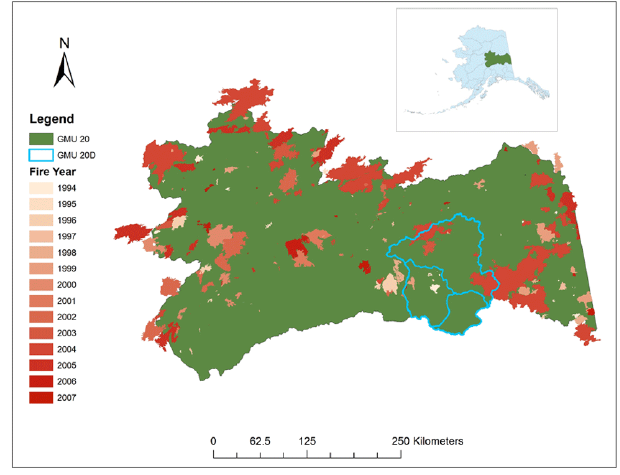
Fig. 2 . Map of burns across game management unit 20. The region highlighted with a blue line represents the location of our case study in game management unit